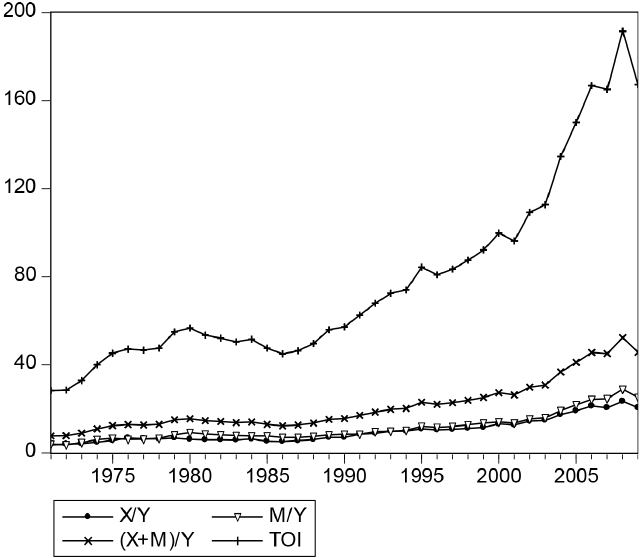
Fig. 1. Trade openness indicators